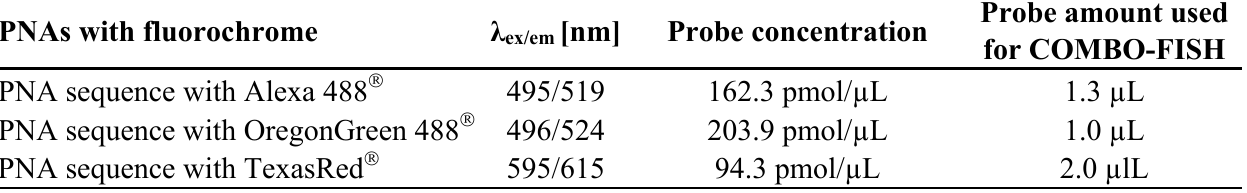
Table 1. PNAs labeled with different dyes (with excitation  and their amounts used for specimens in this article. All probes were specific for centromere 9.